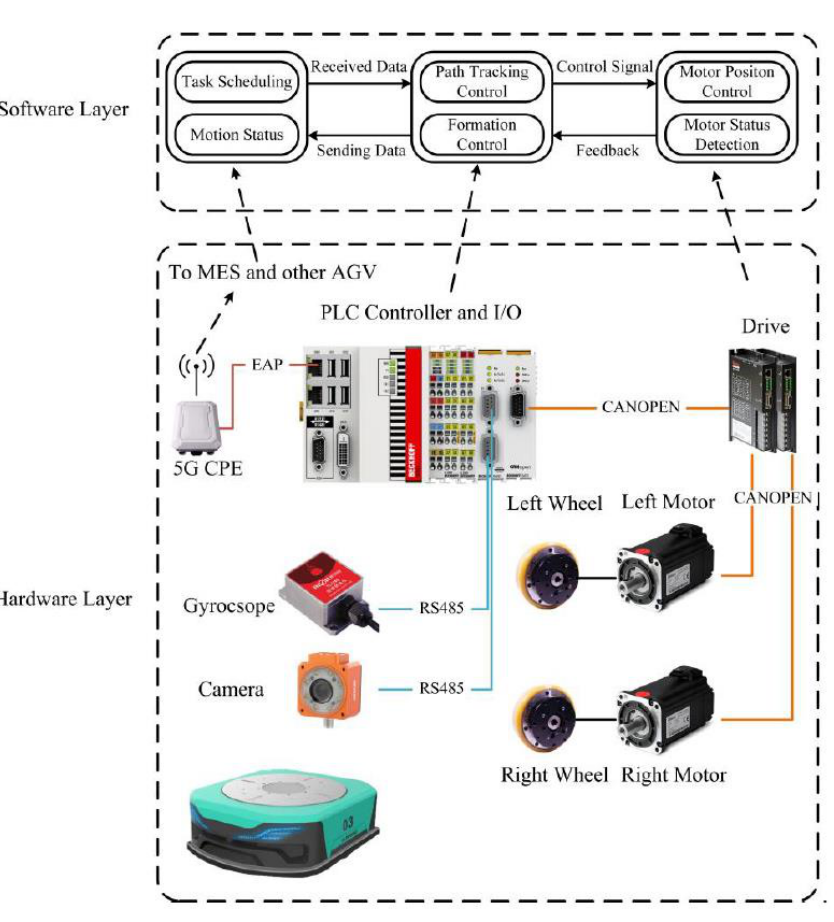
Figure 10. Experiment AGV system architecture. Three optoNCDT 1420 laser sensor of Micro-Epsilon are used to measure the